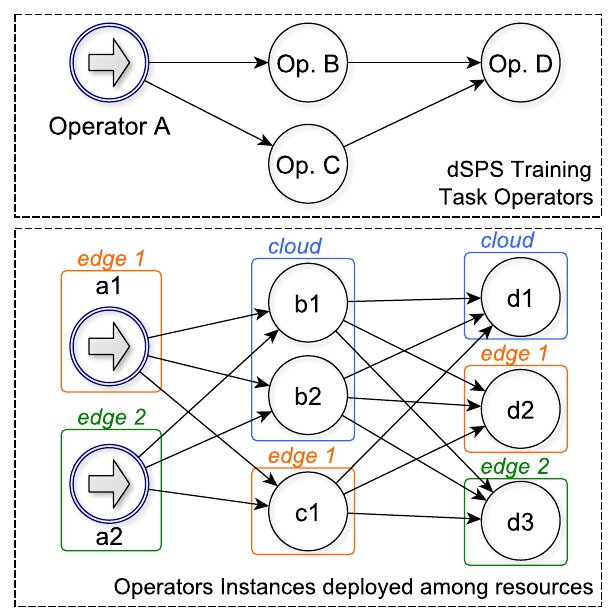
Figure 5. Training Tasks Operators of the dSPS. In this example we show an instance where data managed by the operator A is sensitive, thus the RM deploys operator instances a1 and a2 only on the two edge nodes. Operator B can instead be performed in the Cloud, while Operator C, which produces the AI Inference Engine, is available on all